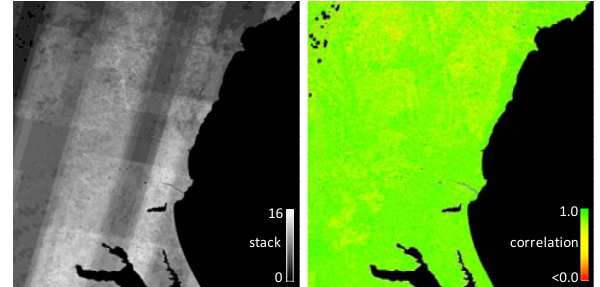
Figure 6. Maps of stacking numbers (left) and correlation (right) in the tile of